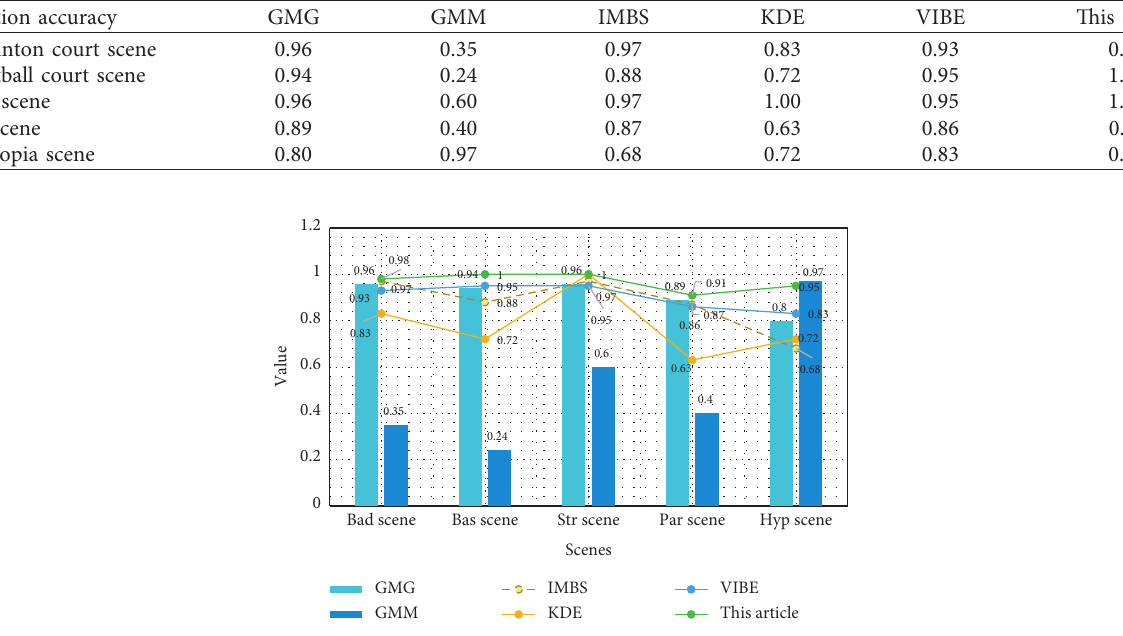
Figure 6: The accuracy index map of scene detection for dynamic background video library. Table 6: Data of recall rate index for dynamic background video library scene detection.